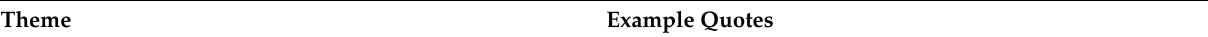
Table 4. Themes describing program content and characteristics as described by